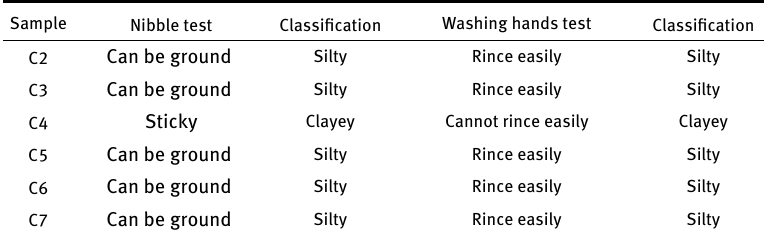
Table 4: Nibble and washing hands tests results.